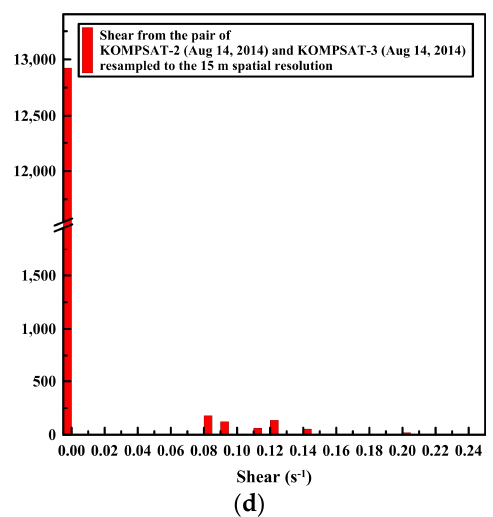
Figure 14. The histogram of the sea ice deformation using the same image pair with Figure 13: the histograms of divergence from ( a ) the image pair resampled to the spatial resolutions of 4 m; and ( b ) the same image pair resampled to the spatial resolutions of 15 m, and the histograms of shear from ( c ) the image pair resampled to the spatial resolutions of 4 m; and ( d ) the same image pair resampled to the spatial resolutions of 15 m.